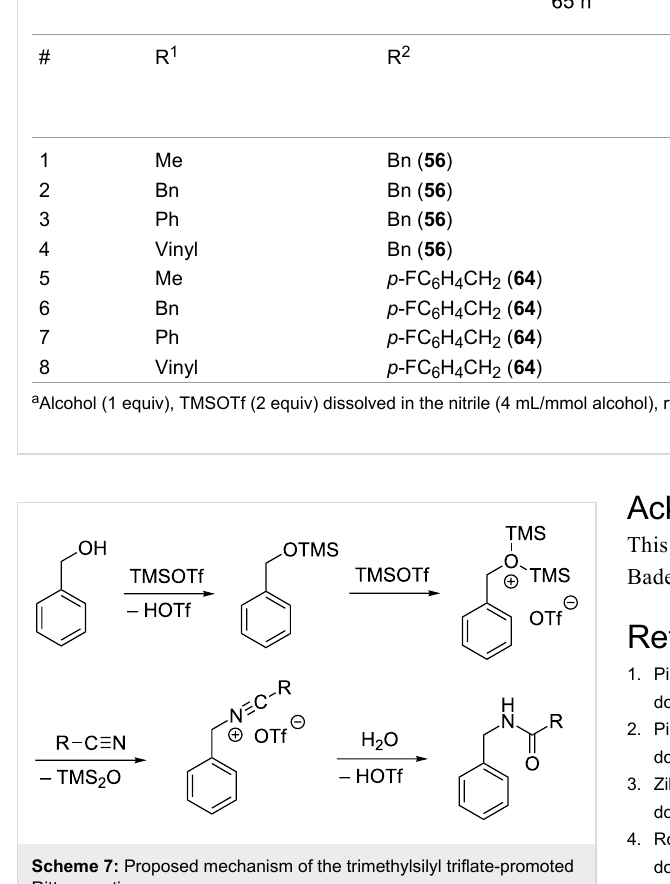
carboxamide. Apparently the double silylation is not possible with electron-deficient